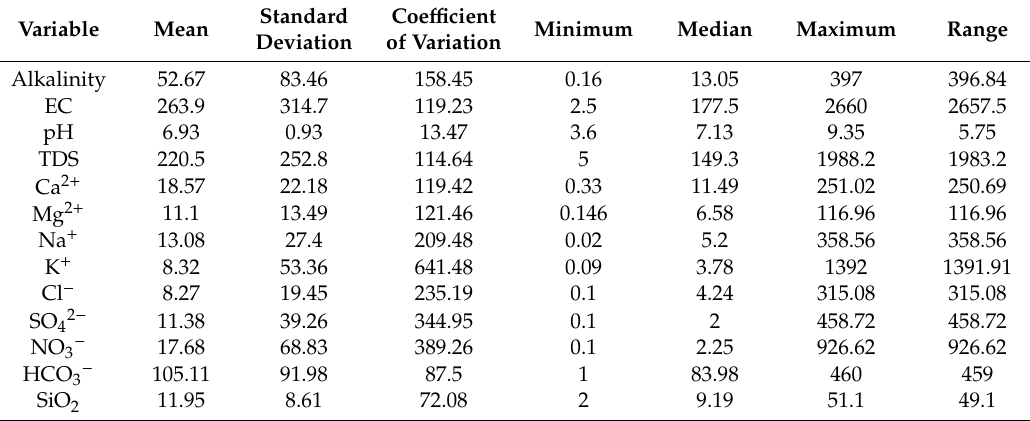
Table 1. Descriptive statistics of the hydrochemical parameters. Alkalinity; Electric Conductivity (EC,) potential hydrogen (pH); Total Dissolved Solids (TDS), calcium (Ca 2 + ); magnesium (Mg 2 + ); sodium (Na + ); potassium (K + ); chloride (Cl − ); Sulphur dioxide (SO 42 − ); nitrate (NO 3 − ); bicarbonate (HCO 3 − ); silicon oxide (SiO 2